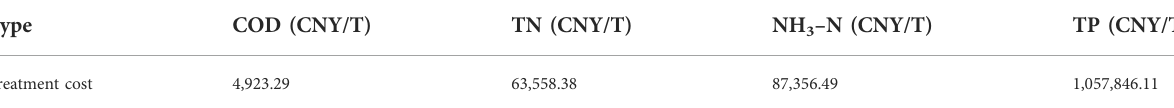
TABLE 3 Unit treatment cost of different pollutants in Changzhou